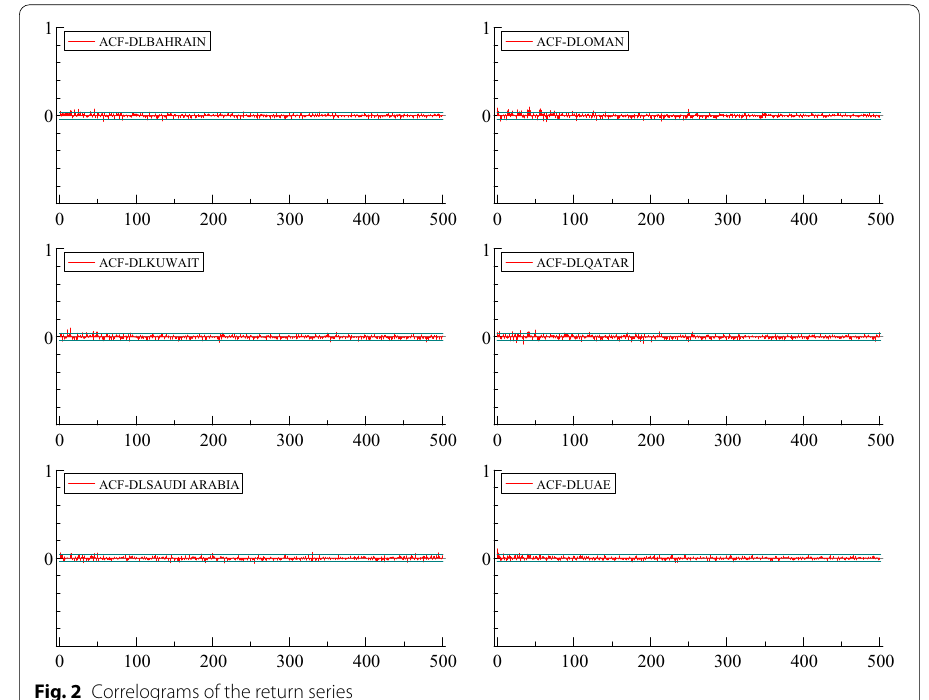
Fig. 2 Correlograms of the return